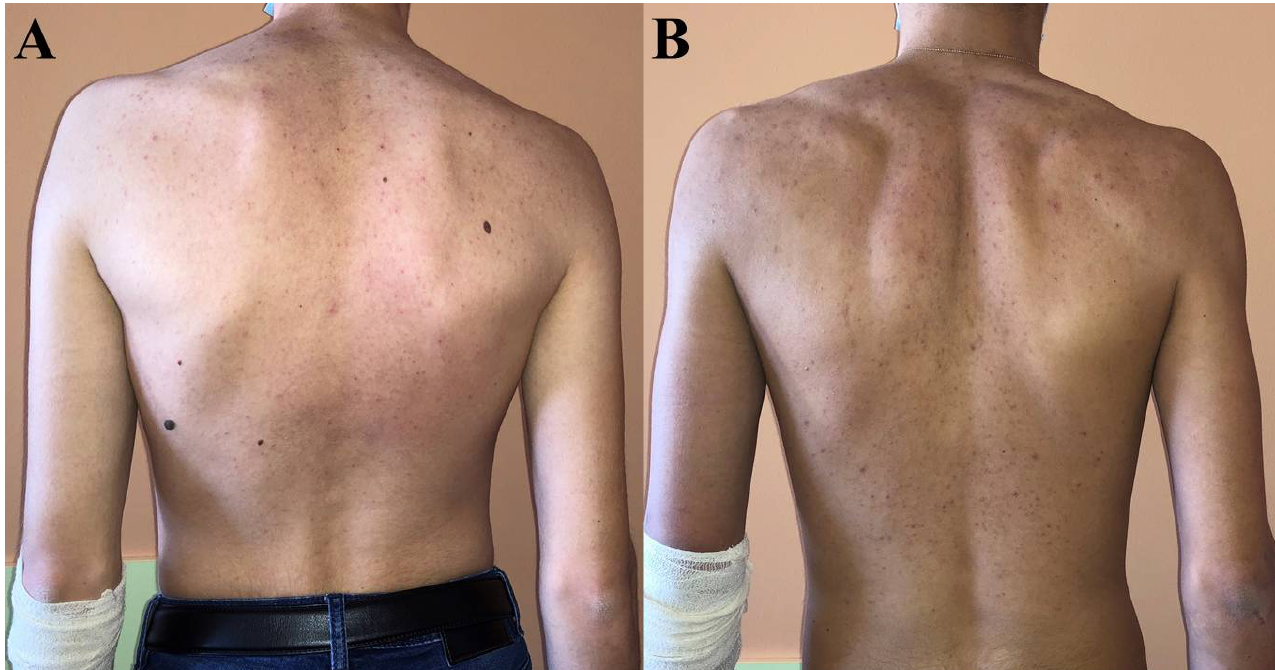
Figure 2. Skin coloration at last visit in patient 1 (A) and patient 2 (B). Patient 2 was significantly more hyperpigmented—particularly around elbows—than patient 1 who had the same skin tone as their parents and patient 3.